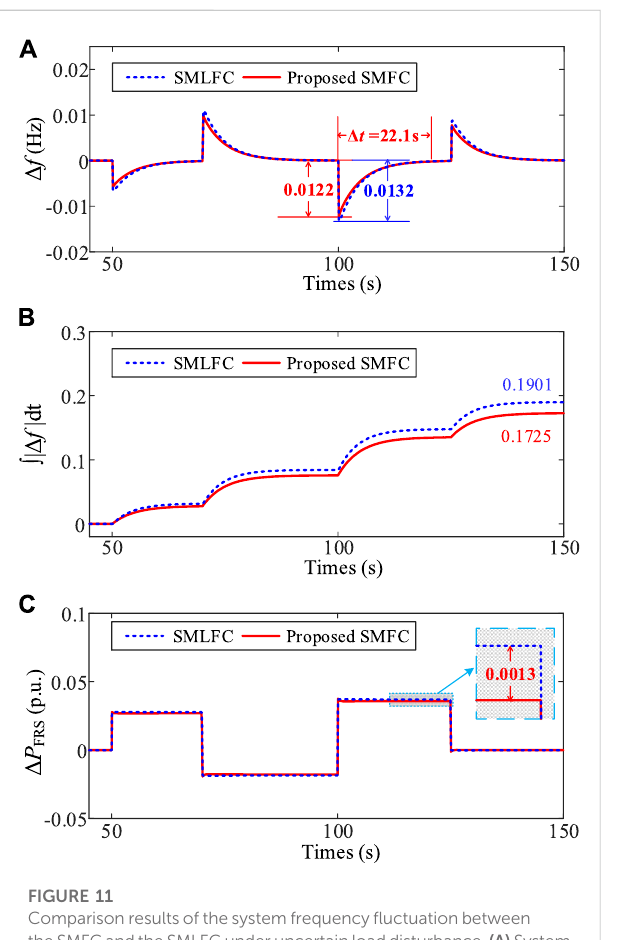
FIGURE 12 Comparisonresultsofthesystemfrequency fl uctuationbetween theSMFC and theSMLFC under uncertain wind speed disturbance. (A) System frequency fl uctuation. (B) Total frequency fl uctuation level , | Δ f |dt. (C) Power output deviation of